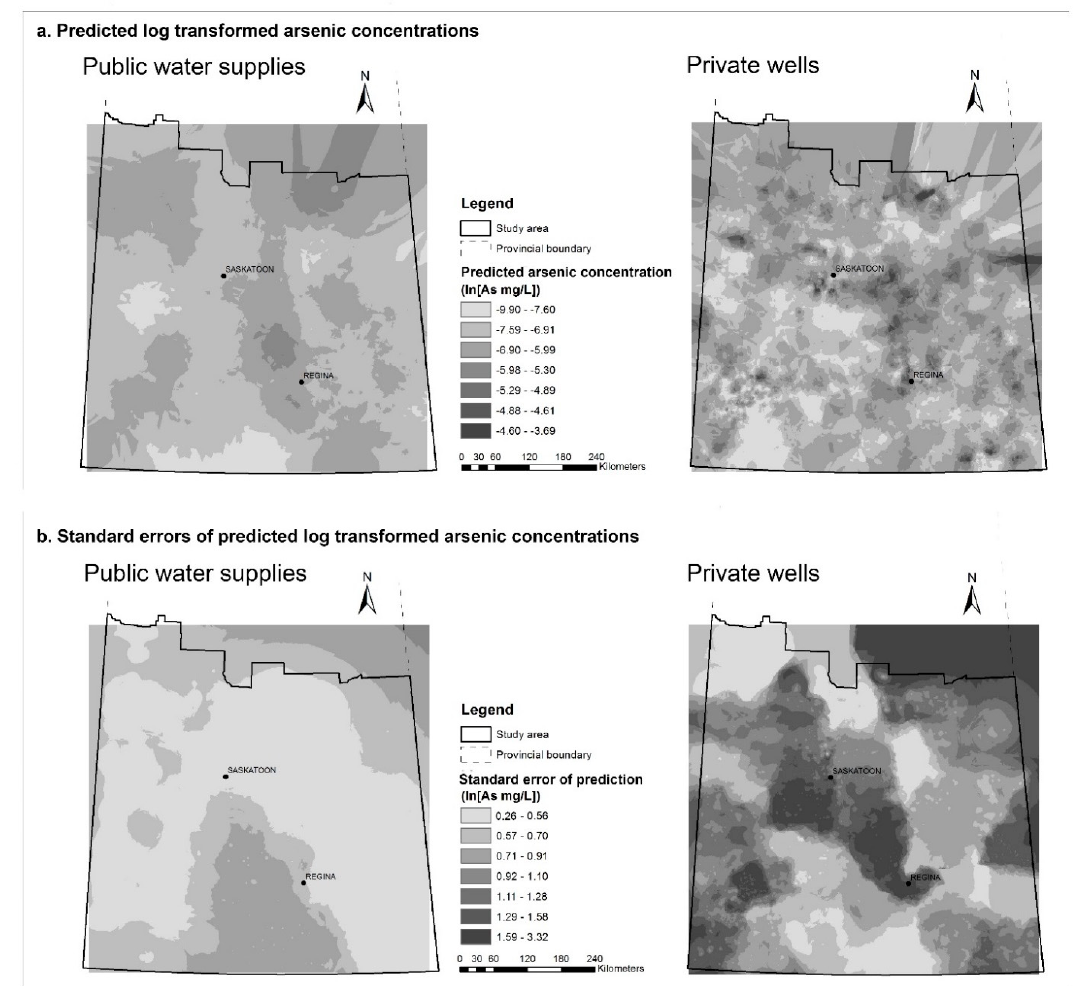
Figure 3. Empirical Bayesian kriging prediction maps for natural logarithm transformed arsenic concentrations ( a ); and the prediction standard error maps ( b ) for public supplies (left) and private supplies (right) in study area in southern Saskatchewan.